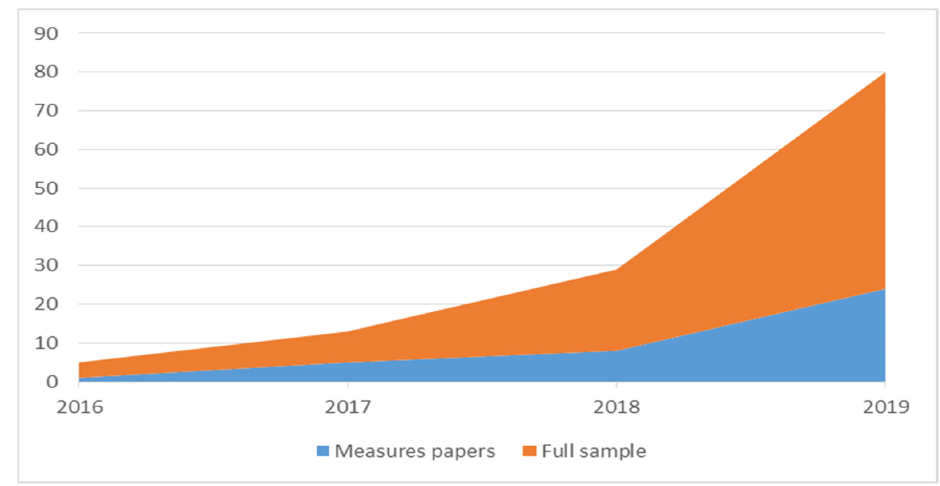
Figure 1. Trends in overtourism publications: papers with measurements vs. full sample.